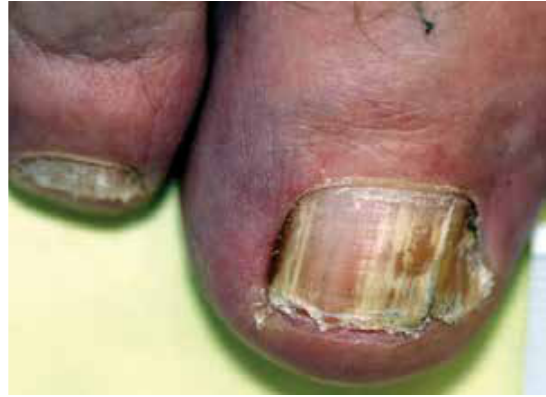
Figure 6: Tinea unguium (Image available from http://lermagazine.com/article/onychomycosis-